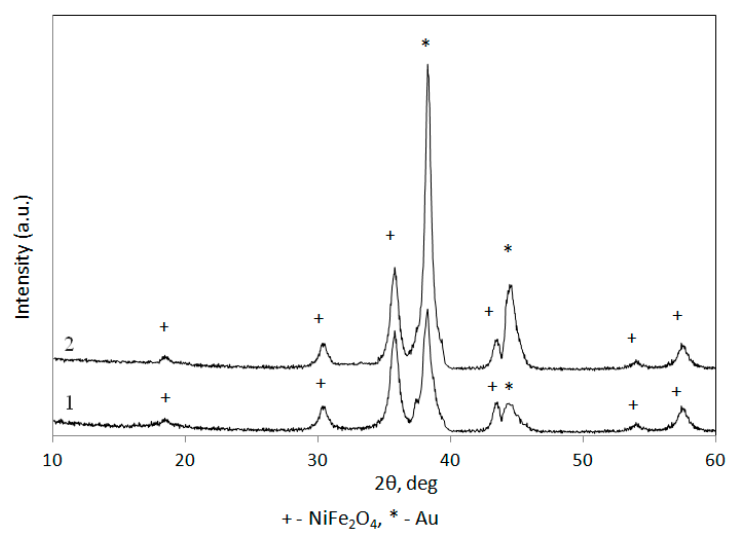
Figure 4. XRD patterns of NiFe 2 O 4 @Au NPs after gold deposition under conditions in Figure 2: (curve 1) Two-stage coating and (curve 2) three-stage coating.